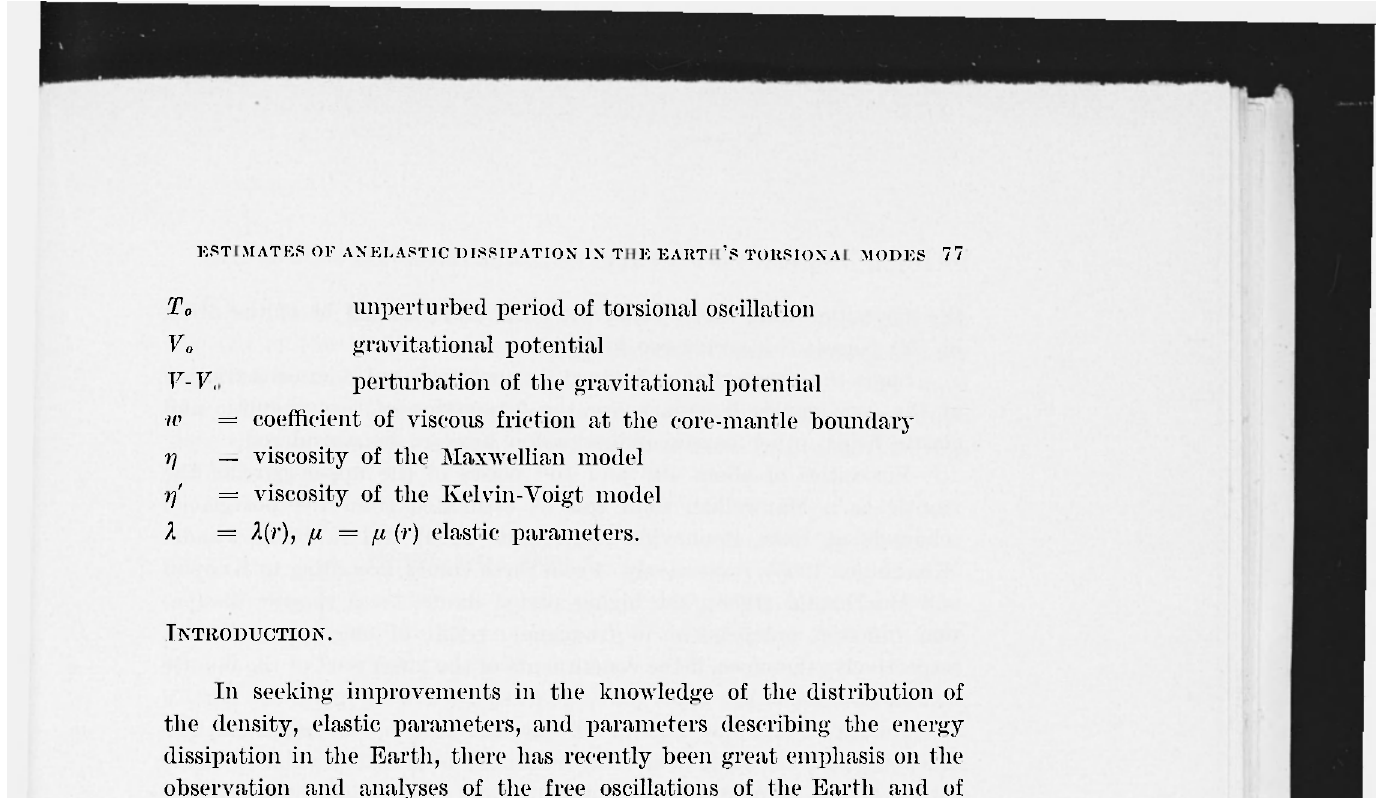
w = coefficient of viscous friction at the core-mantle boundary ')] — viscosity of the Maxwellian model rf = viscosity of the Kelvin-Voigt model A = A(r), ji = ¡x (r) elastic